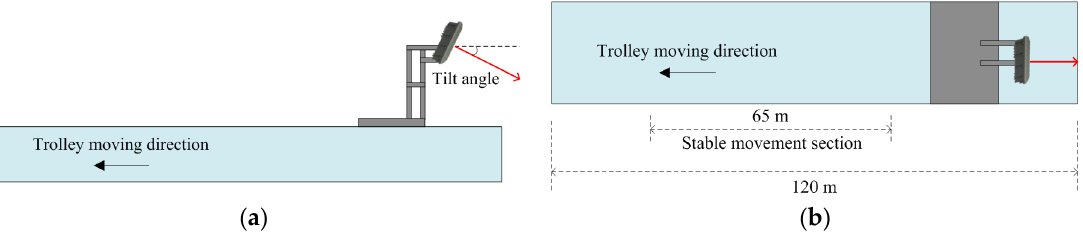
Figure 4. Schematic diagram of the experimental setup in the laboratory for the current meter calibration: ( a ) lateral view; and ( b ) top view.